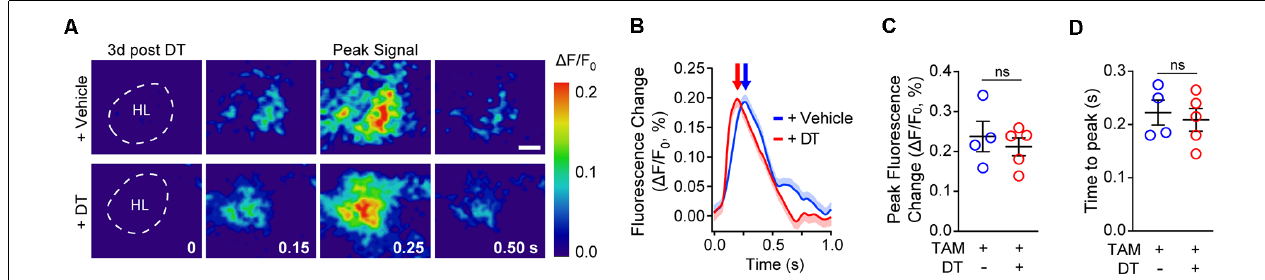
FIGURE 3 | Cortical neuronal activity determined by voltage-sensitive dye (VSD) imaging in response to sensory stimulation in pericyte-CreER; iDTR mice 3 days post-DT treatment. (A) Representative pseudocolored image sequences of cortical depolarization pattern in the hind limb S1 cortical region obtained by VSD imaging in response to a 300 ms hind limb mechanical stimulus in TAM-treated pericyte-CreER; iDTR mice treated with DT or vehicle determined 3 days post-DT or vehicle treatment. The dashed line indicates hind limb (HL) region. Peak signals and peak signal times are indicated. Scale bar = 0.25 mm. (B–D) Representative VSD intensity traces from individual mice (average ± SEM for 10 trials per mouse; B ), average peak fluorescence change (C) , and average time to peak (D) in pericyte-CreER; iDTR mice 3 days post-DT or vehicle treatment. In (C , D) , mean ± SEM, from n = 4–5 mice per group; circles denote individual values per mouse. ns, non-significant by Student’s t